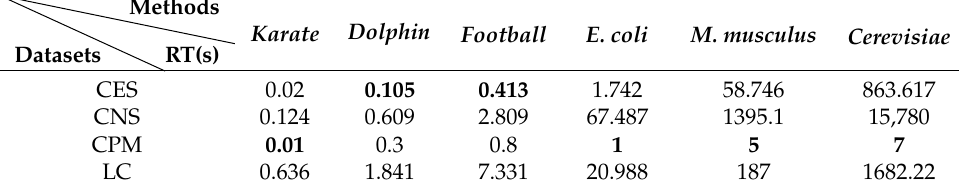
Table 2. The comparison of the algorithms’ running